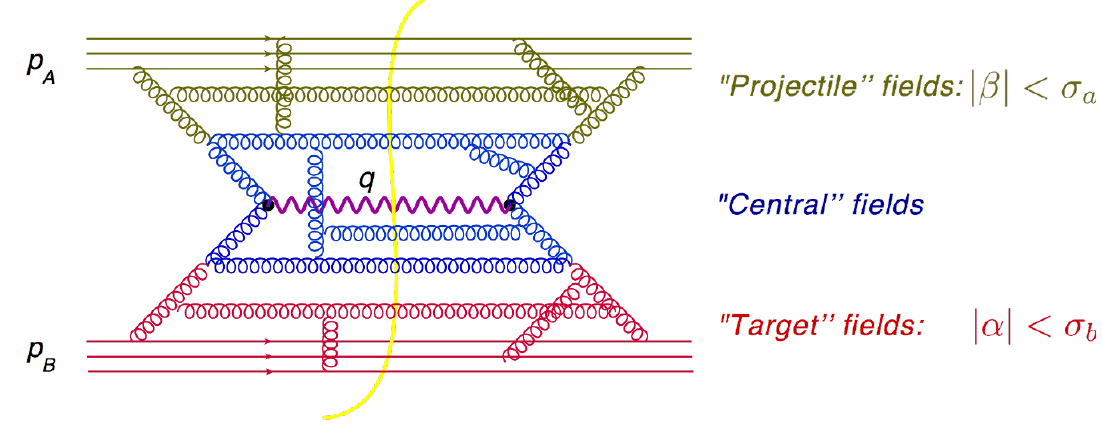
Figure 2 . Rapidity factorization for particle